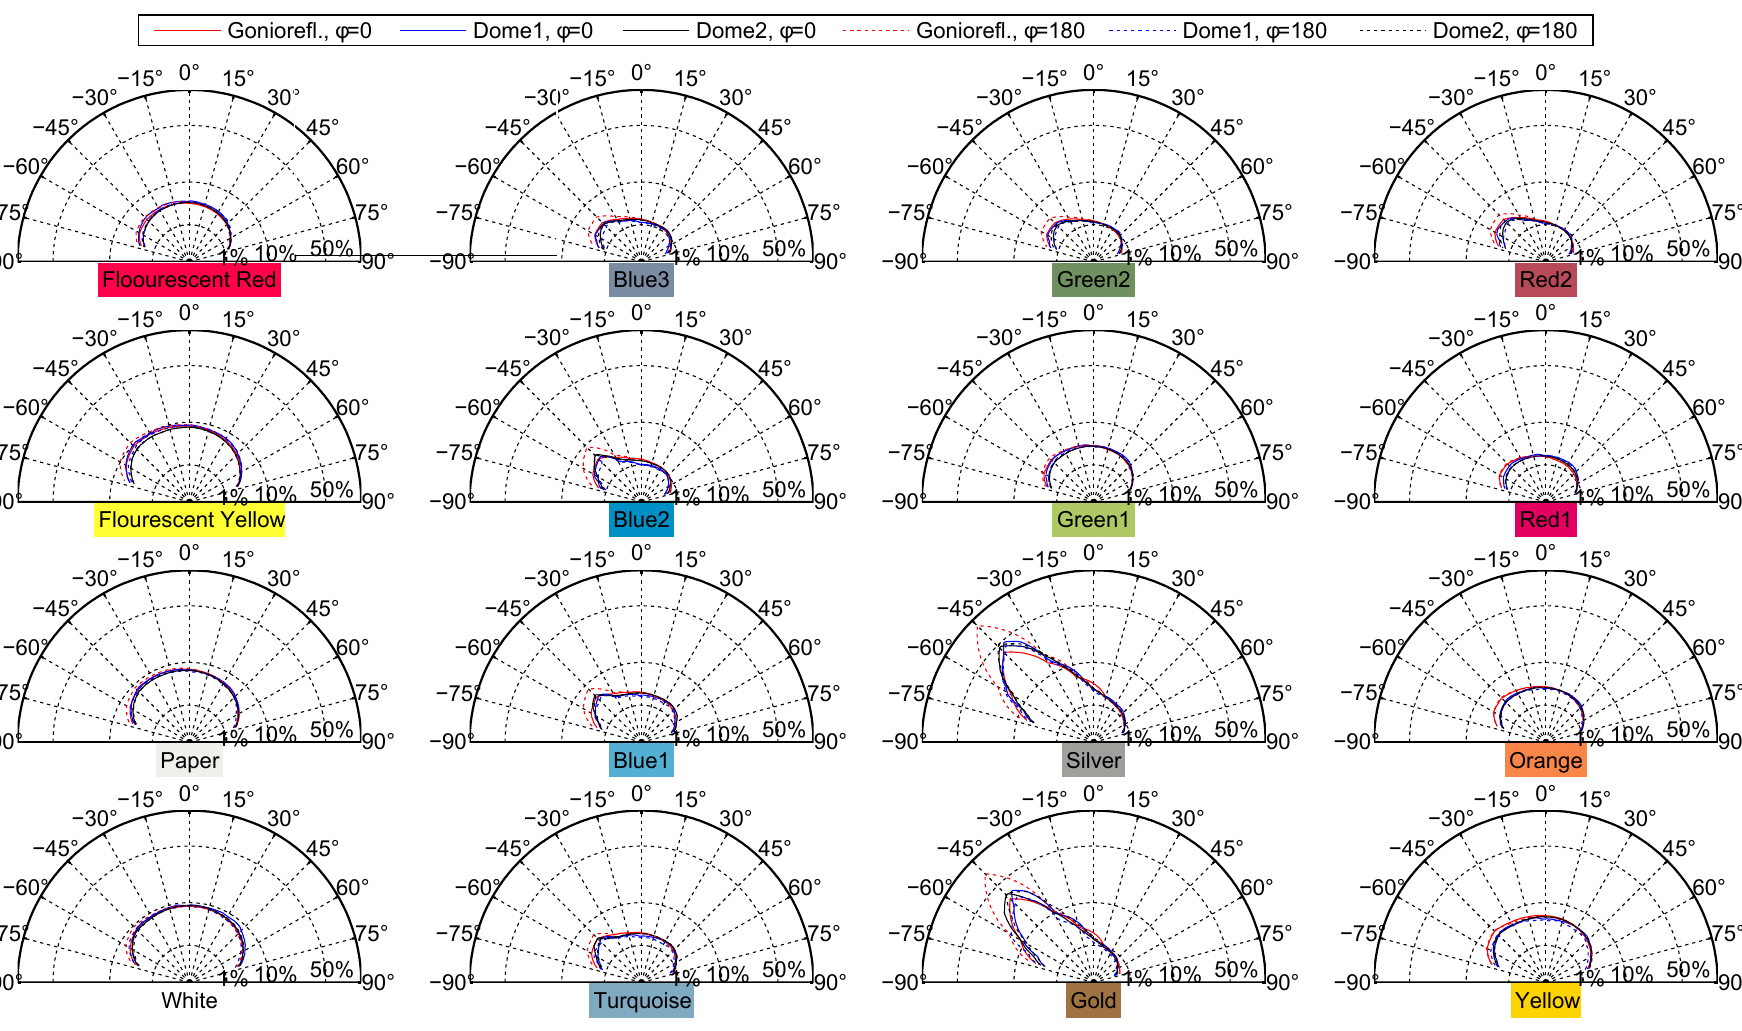
Figure 19. Polar plots of the reflectance distributions shown in Figure 18. The plots show the average reflectivity over all color channels in percent for the respective elevation angles of the light directions. Please refer to the caption of Figure 18 for details about the depicted angles. For the purpose of visualization, the axes are scaled with 3 √